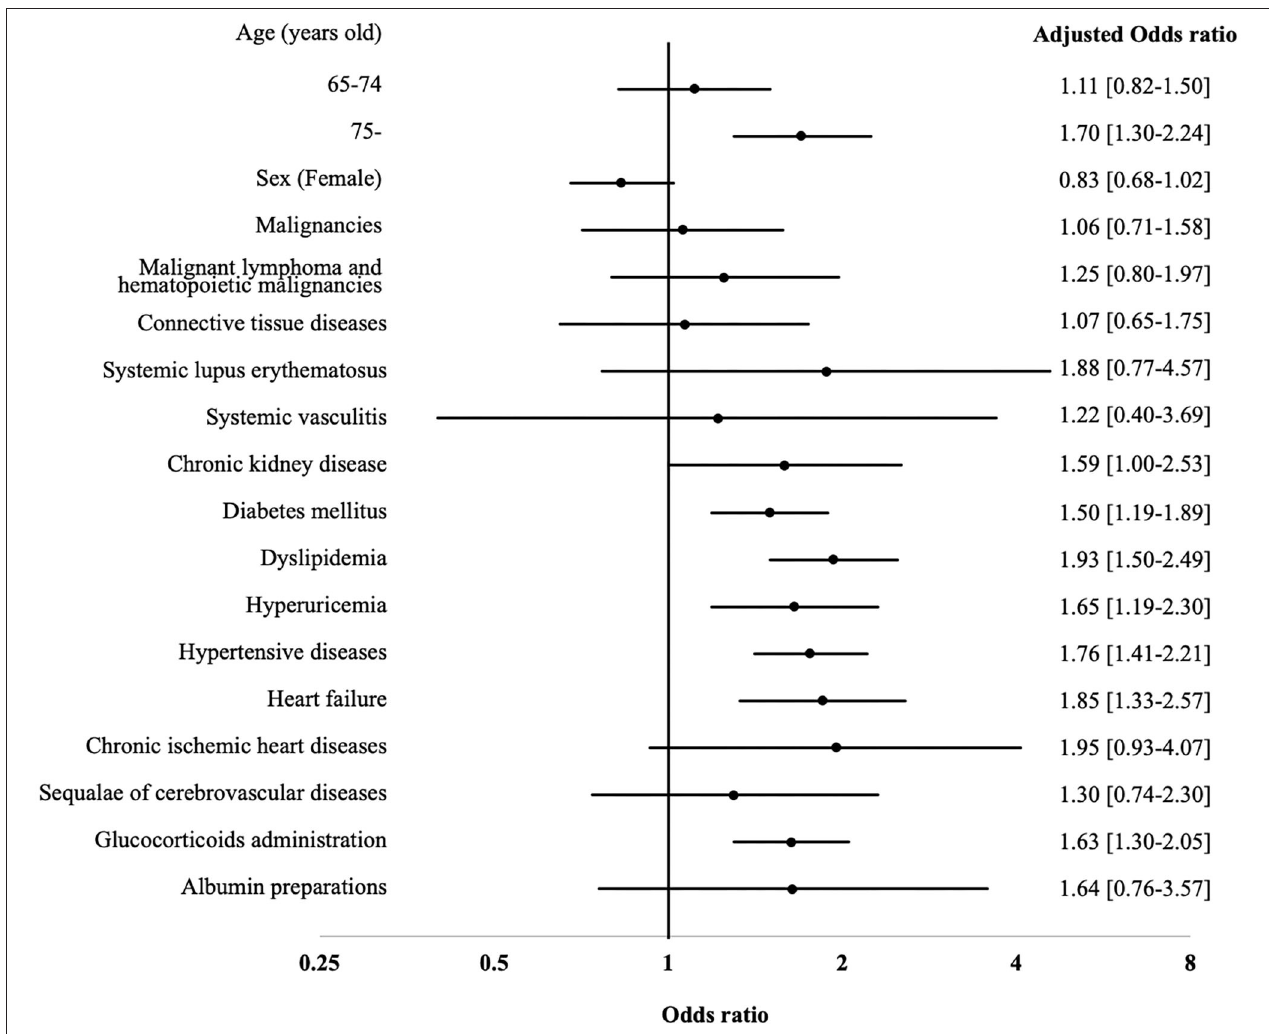
FIGURE 4 | Predictors for risk factors of C-CVE onset after hospitalization. aOR, adjusted odds ratio; C-CVE, cerebro-cardiovascular events; 95% CI, 95 percent confidence